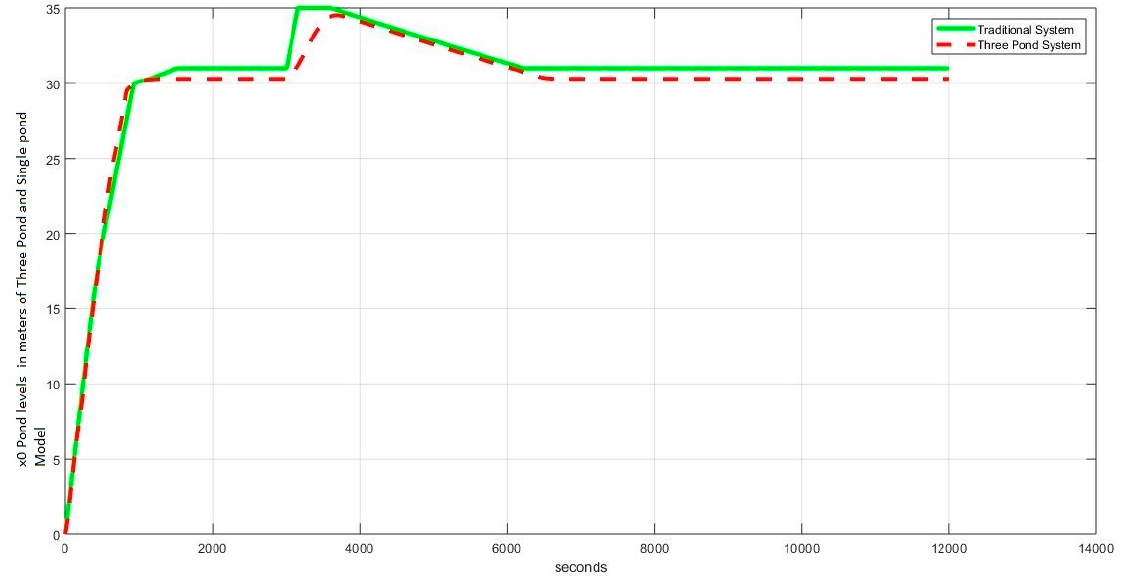
Figure 29. Comparison between the traditional system and the proposed system (half) (positive surge).